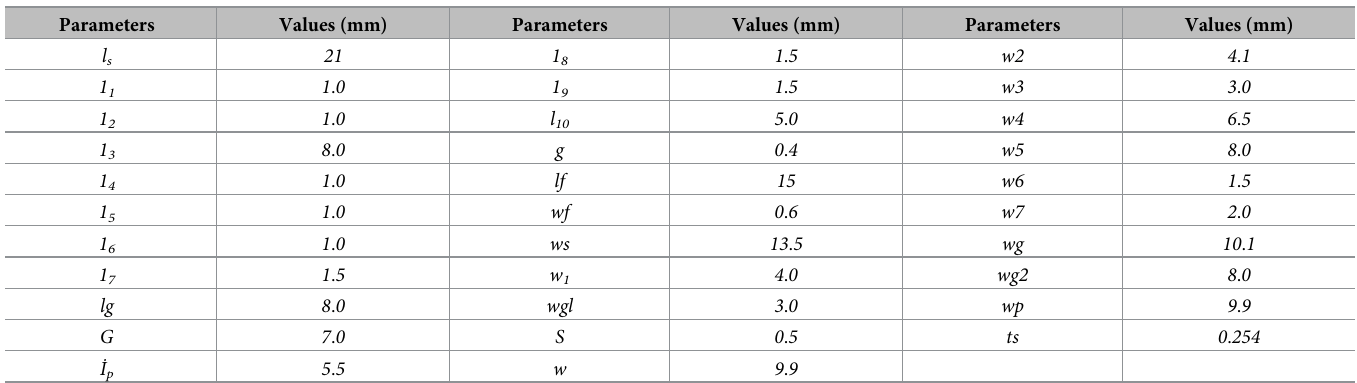
Table 2. List of optimized parameters for the proposed